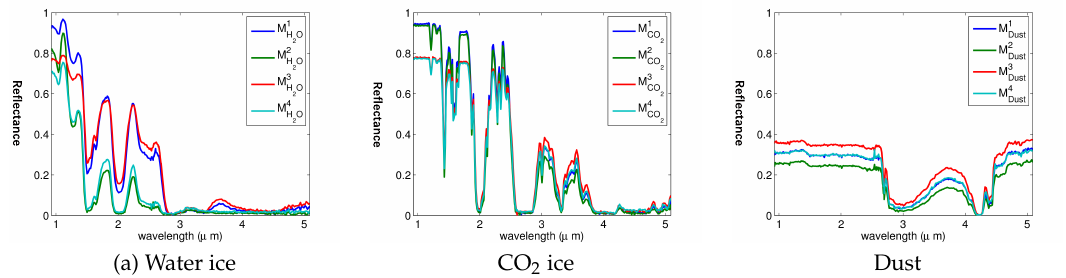
Figure 3. Spectral variations of the three endmembers (H 2 , CO 2 and dust) caused by different solar angles ( θ ) and different grain sizes ( G ). The spectra are shown when the two parameters form a combination of extreme